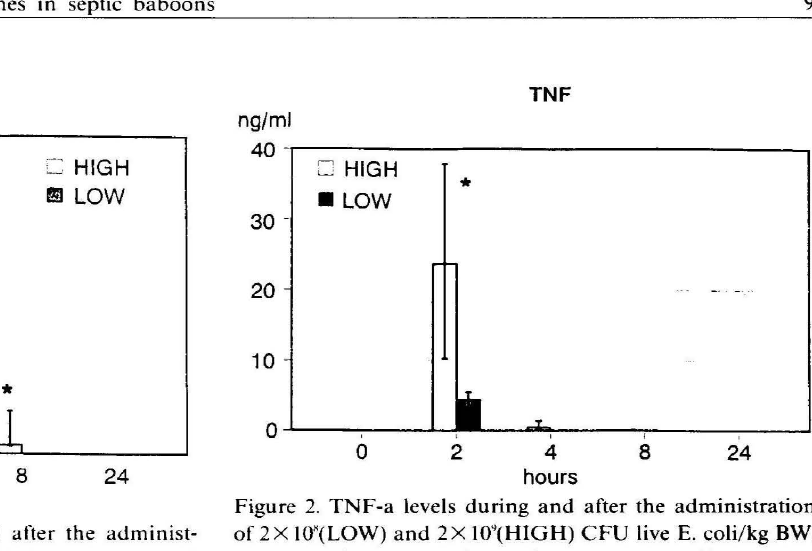
Figure I. Endotoxin levels during and after the administ ration of 2X IO'(LOW) and 2X W"(HIGH) CFU live E. coli/ kg BW. Data are given as median and quarter percentiles.